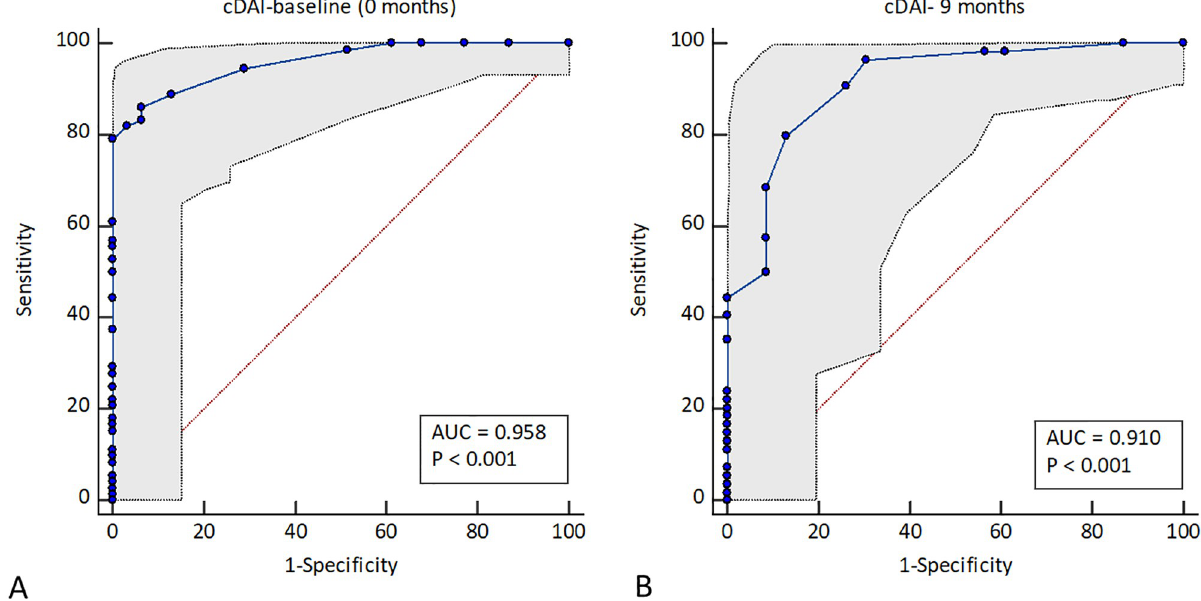
Fig 3. ROC curves. A . ROC curve illustrating the sensitivity and 1-specificity for different values of CDAI corresponding to a DAS28 cut off value of 5.1, based on the disease activity evaluation at the first visit (0 months). Circles on the ROC curve corresponds to different criterion values of CDAI, B . ROC curve illustrating the sensitivity and 1-specificity for different values of CDAI corresponding to a DAS28 > 2.6, based on the disease activity evaluation at 9 months. Optimum CDAI cut-off point were decided based on the Youden’s J statistic. Circles on the ROC curve corresponds to different criterion values of CDAI. CDAI–clinical disease activity, DAS 28- disease activity score